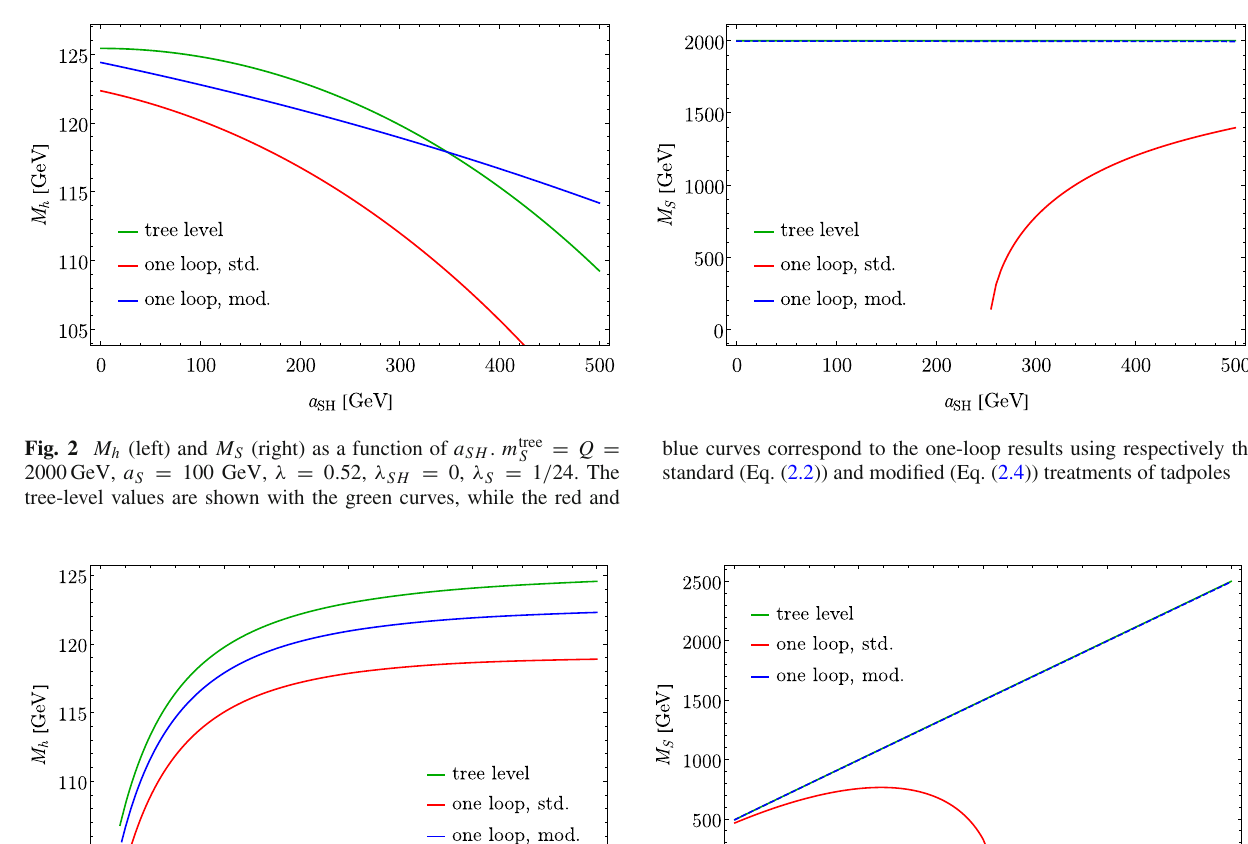
. Q = m tree , a SH = 150 GeV, a S = 100 GeV, λ = 0 . 52, λ SH = 0, λ S = 1 / 24. The colours S S